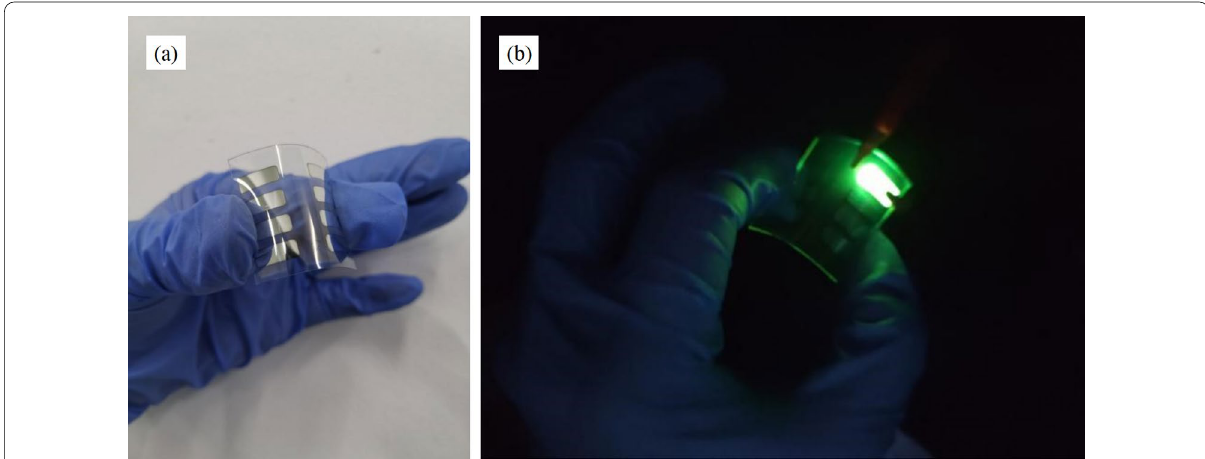
Fig. 9 The OLED and light-emitting physical diagram. a Diagram of flexible green light OLED, b luminescent image of the